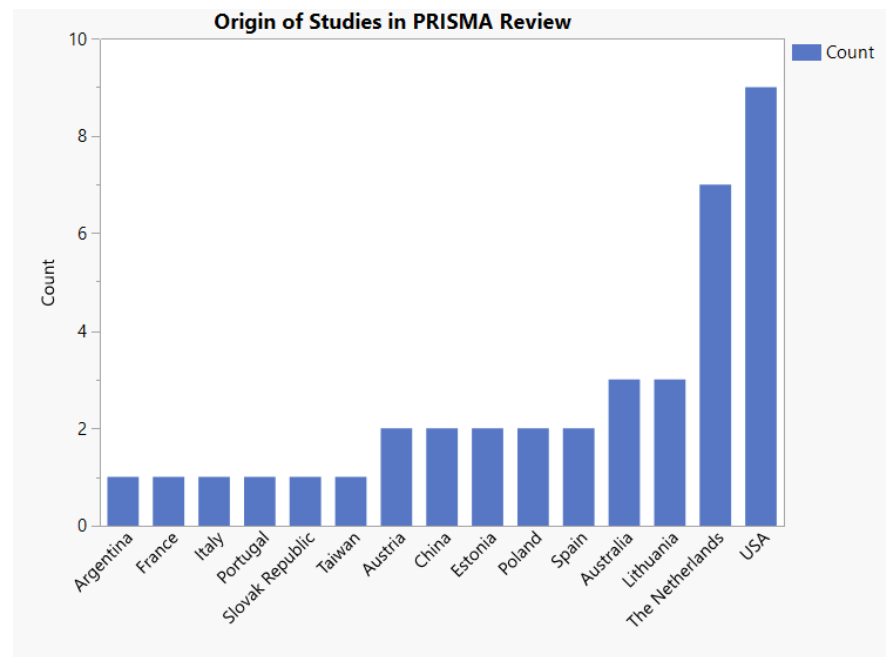
Figure 4. Countries of origin for the first author’s institution across the 38 studies related to AFEA, beverages, and/or packaging.